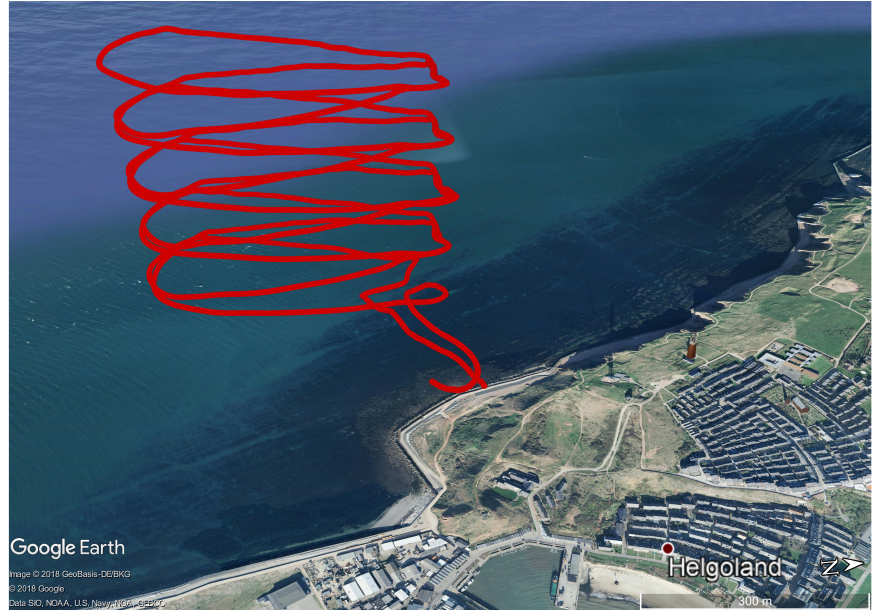
Figure 9. Flight path in red on Helgoland (HEL) on 10 October 2014. The figure shows the flight path on the west coast of Helgoland. The undisturbed marine boundary layer with strong winds from the southeast was